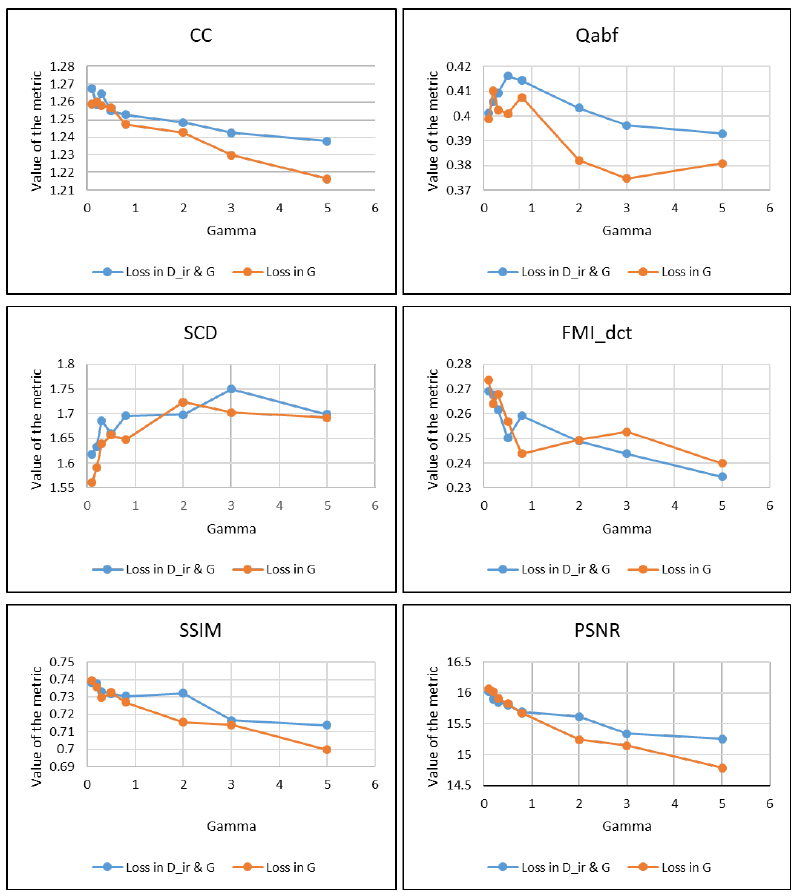
Figure 4. Values of each metric for images from RoadScene Dataset with different γ . Lambda is fixed to 0.5 for this analysis. Type of the loss used is shown in the legends.